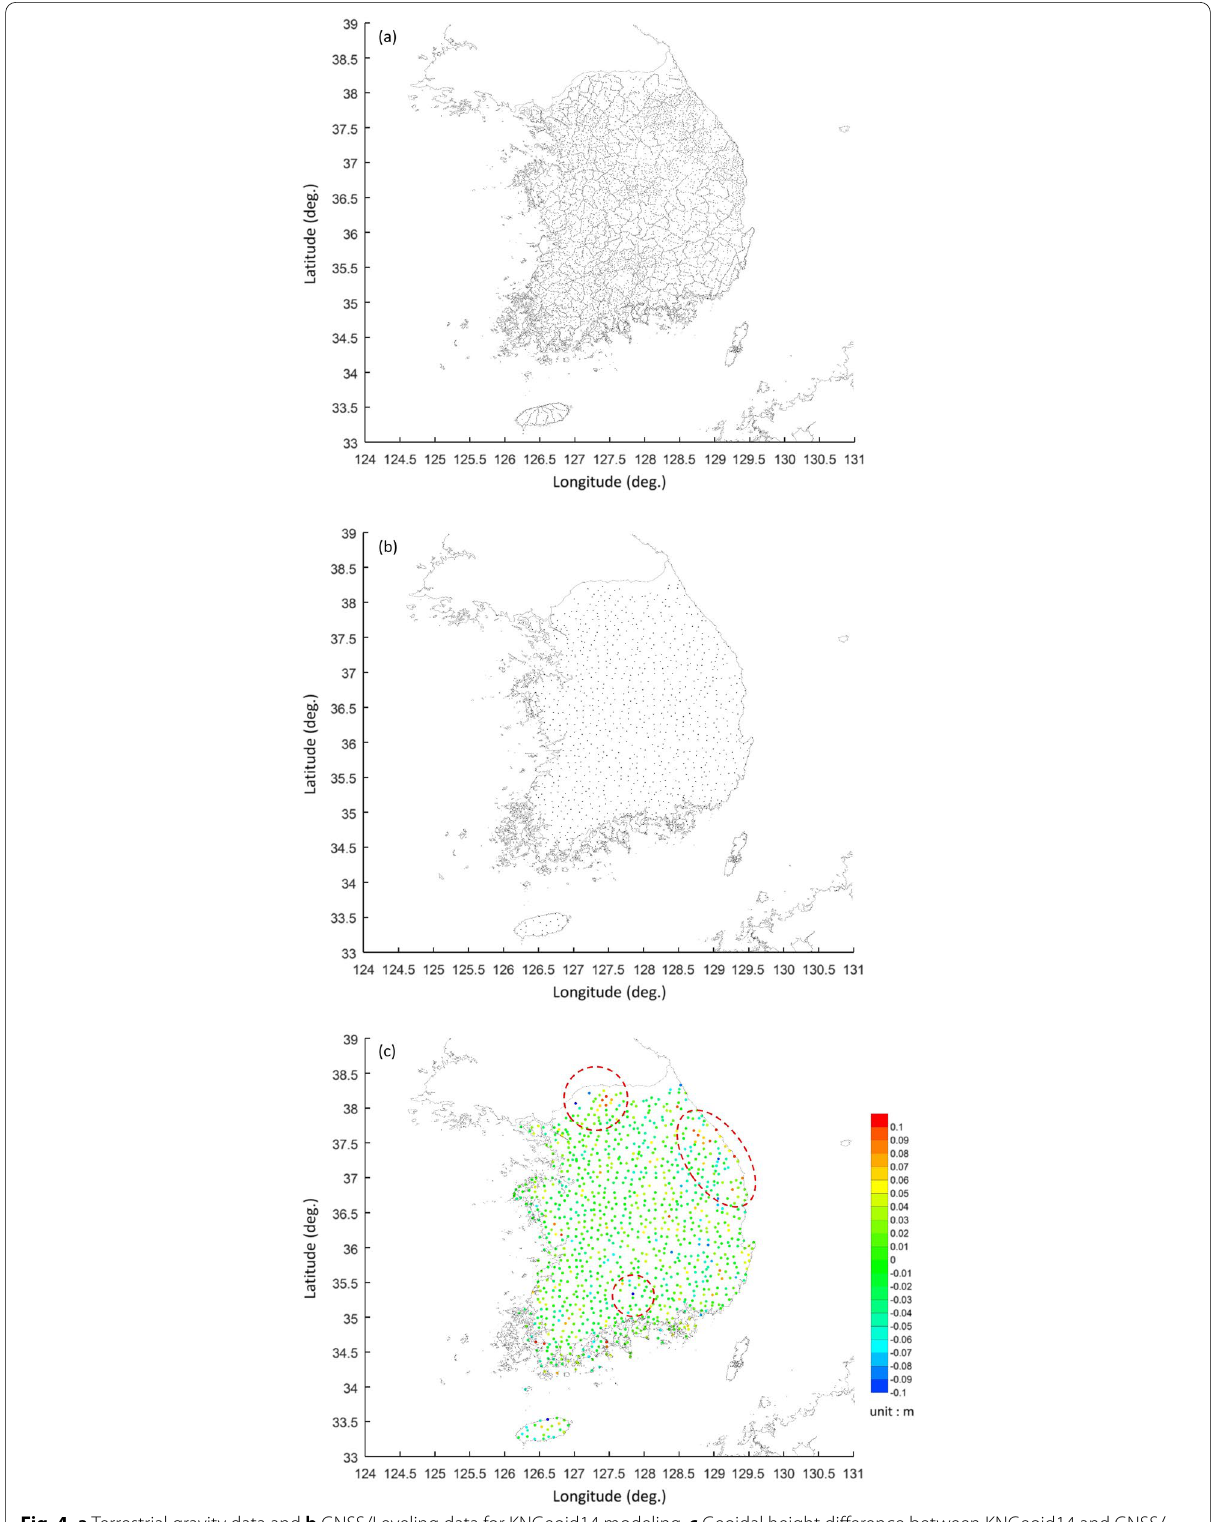
Fig. 4 a Terrestrial gravity data and b GNSS/Leveling data for KNGeoid14 modeling. c Geoidal height difference between KNGeoid14 and GNSS/ Leveling data obtained by the NGII [re-plotted referring to the fundamental data and KNGeoid14 model of Kwon et al.